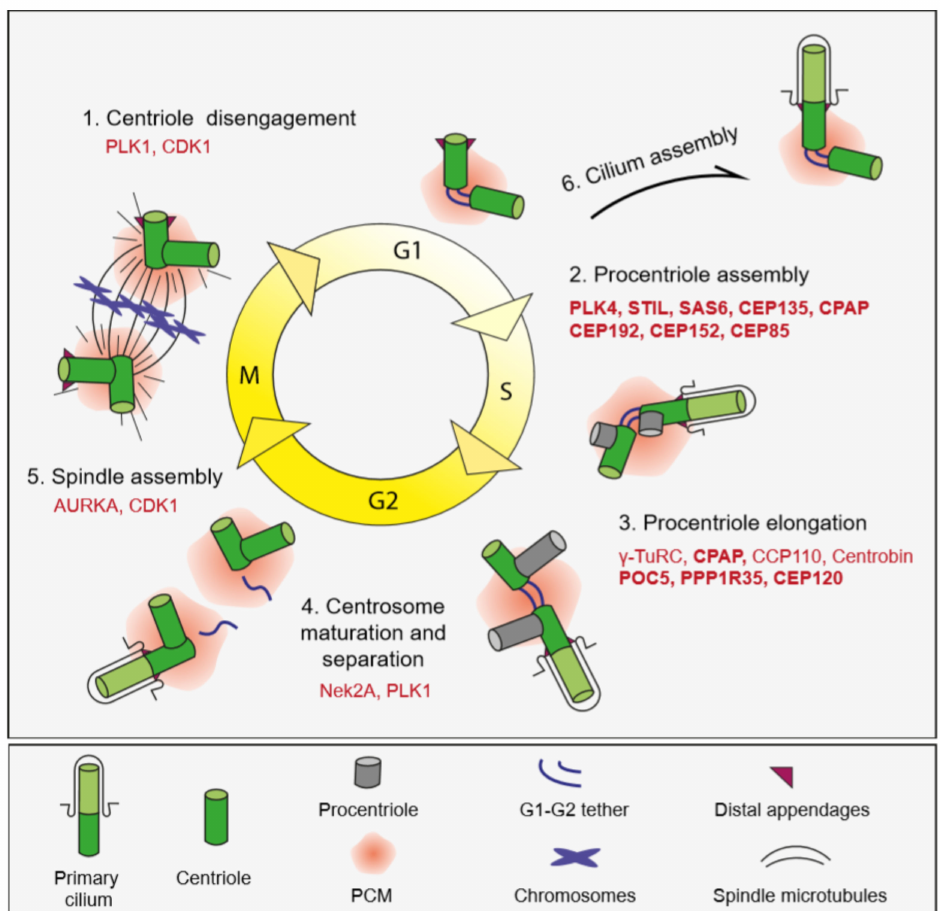
Figure 2. Regulation of the centriole and cilium biogenesis during the cell cycle. Centriole and cilium biogenesis are highly regulated, multi-step processes that are tightly linked to the cell cycle. In the G1 phase, the majority of animal cells have one centrosome composed of a pair of centrioles tethered by the G1-G2 tether at their proximal ends. At the G1 and S phases the two centrioles duplicate only once such that one procentriole forms adjacent to each pre-existing parental centriole. This step is governed by the sequential centriolar recruitment and activity of a conserved set of proteins including the kinase PLK4, the sca ff old STIL and the building block of the cartwheel SASS6 along with regulators of these proteins. Following initiation of centriole duplication, procentrioles elongate throughout S and G2 phases. In late G2, the two centrosomes are separated by the dissolution of the G1-G2 tether. In a process termed centriole-to-centrosome conversion, fully elongated centrioles lose their cartwheel and recruit more PCM material in preparation for bipolar spindle assembly. During mitosis, centrosomes assemble the bipolar spindle, which equally segregates both a pair of centrioles and genetic material to daughter cells. Distal appendages undergo transient disassembly during mitosis. At the end of mitosis, the centriole pairs disengage and lose their orthogonal arrangement. Centriole disengagement relicenses the centrioles for centriole duplication in the next cell cycle. As cells enter quiescence by depletion of growth factors, cilium assembles. Steady-state cilium persists into S / G2 / M phases and completes disassembly close to cytokinesis after nuclear envelope